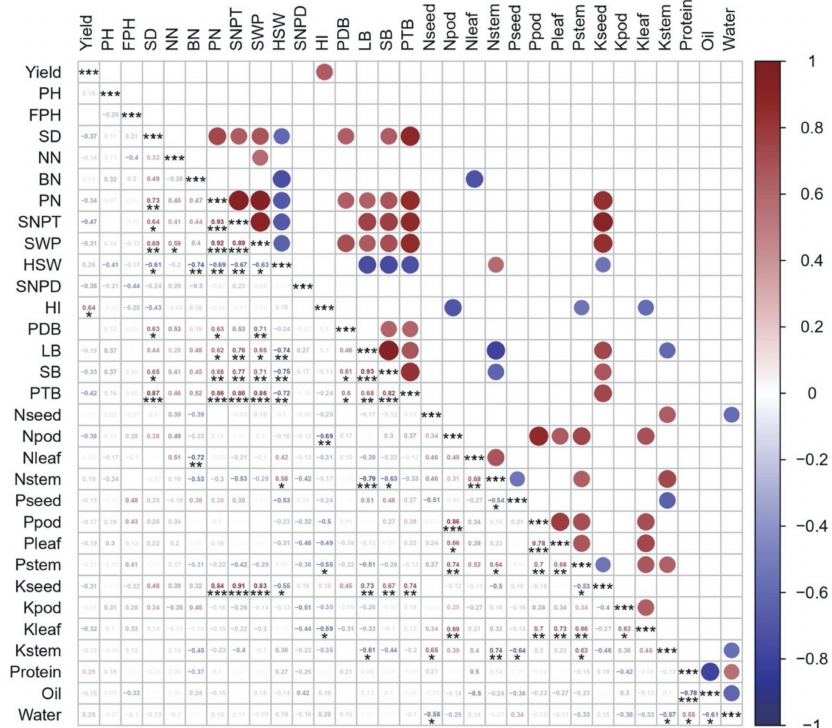
Figure 3. The pairwise correlations (Pearson’s r ) among 31 traits based on the averaged values. The lower diagonal plots show the correlation coefficient, significant differences are indicated by * p < 0.05, ** p < 0.01, *** p < 0.001, values without asterisks were not significant at p < 0.05. The upper diagonal only shows the significant correlations which are represented as colored circles, blue indicating negative correlation, and red indicating positive correlation. Yield, Grain yield; PH, Plant height; FPH, First pod height; SD, Stem diameter; NN, Number of nodes on main stem; BN, Branch number; PN, Pod number; SNPT, Seed number per plant; SWP, Seed weight per plant; HSW, 100-seed weight; SNPD, Seed number per pod; HI, Harvest index; PDB, Biomass per pod; LB, Biomass per leaf; SB, Biomass per stem; PTB, Biomass per plant; Nseed, N content in seed; Npod, N content in pod; Nleaf, N content in leaf; Nstem, N content in stem; Pseed, P content in seed; Ppod, P content in pod; Pleaf, P content in leaf; Pstem, P content in stem; Kseed, K content in seed; Kpod, K content in pod; Kleaf, K content in leaf; Kstem, K content in stem; Protein, Protein content; Oil, Oil content; Water, Water